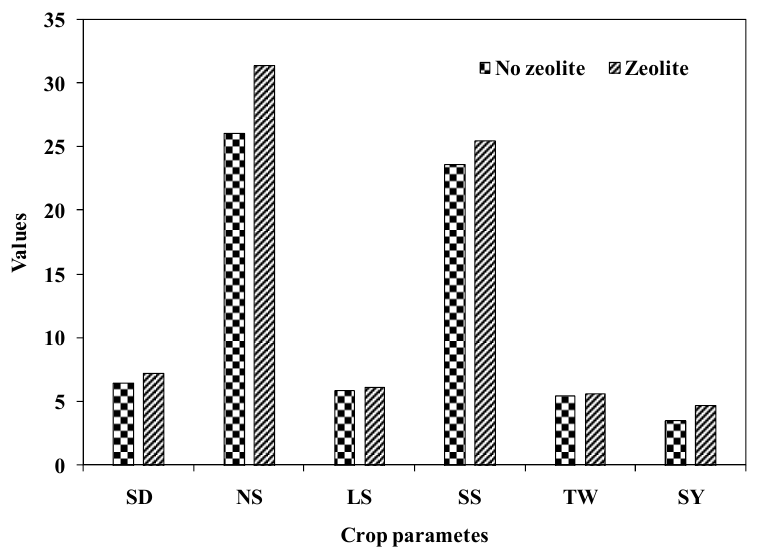
Figure 15. Effects of zeolite on some agronomic traits in canola. SD—Stem diameter (mm); NS— Number of siliquae; LS—Length of siliqua (cm); SS—Seeds per siliqua; TW—Test weight (g); SY— Seed yield (t ha —1 ). Adapted and modified from Zahedi et al. [162].